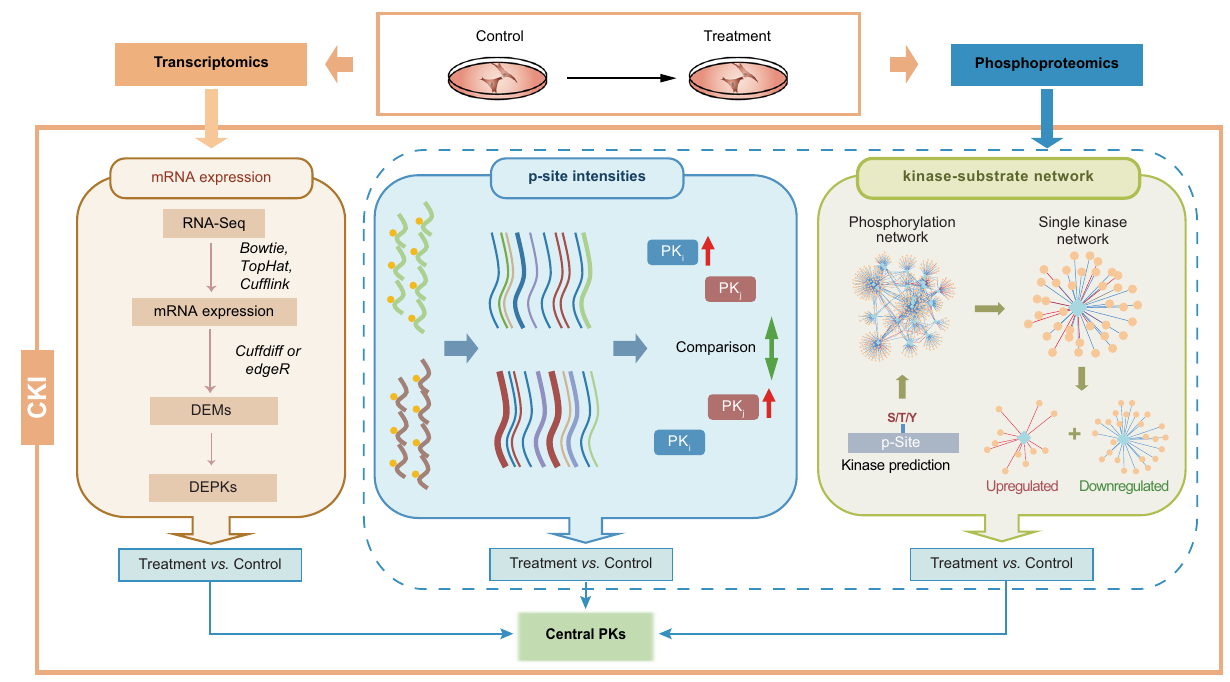
Fig. 1 | Schematic diagram of the CKI algorithm. First, the transcriptomes and phosphoproteomes of control and treated samples in a de fi ned biological process were quanti fi ed by RNA-seq and TMT-based LC-MS/MS technology. Bowtie 53 , TopHat 54 , and Cuf fl inks 55 were used to process the transcriptomic data, then Cuffdiff in Cuf fl inks 55 or edgeR 49 was used to identify differentially expressed